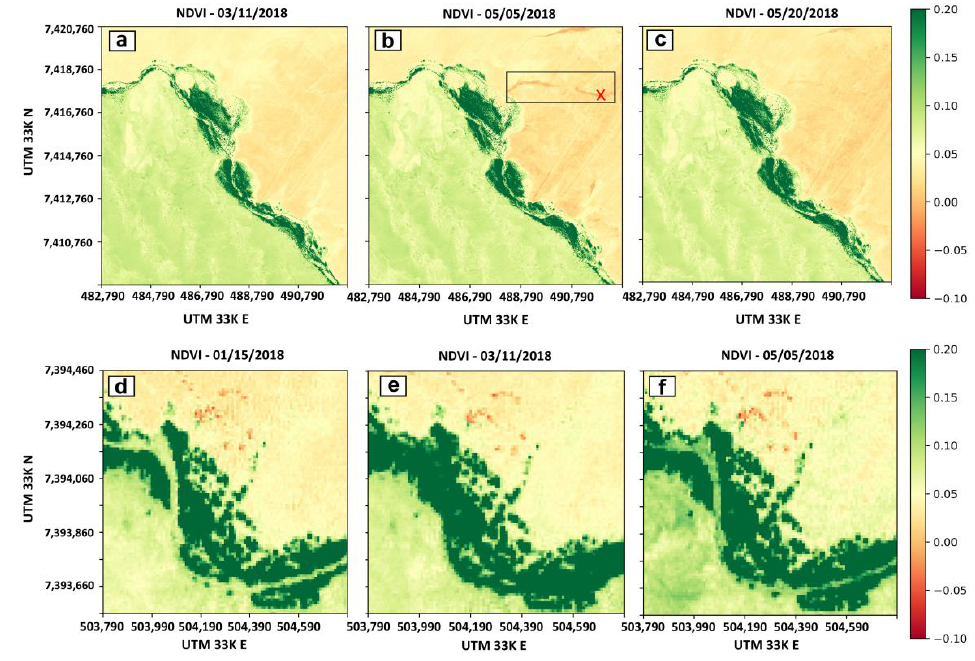
Figure 4. ( a – c ) NDVI maps in the central part (Klipneus) of the lower Kuiseb River acquired at